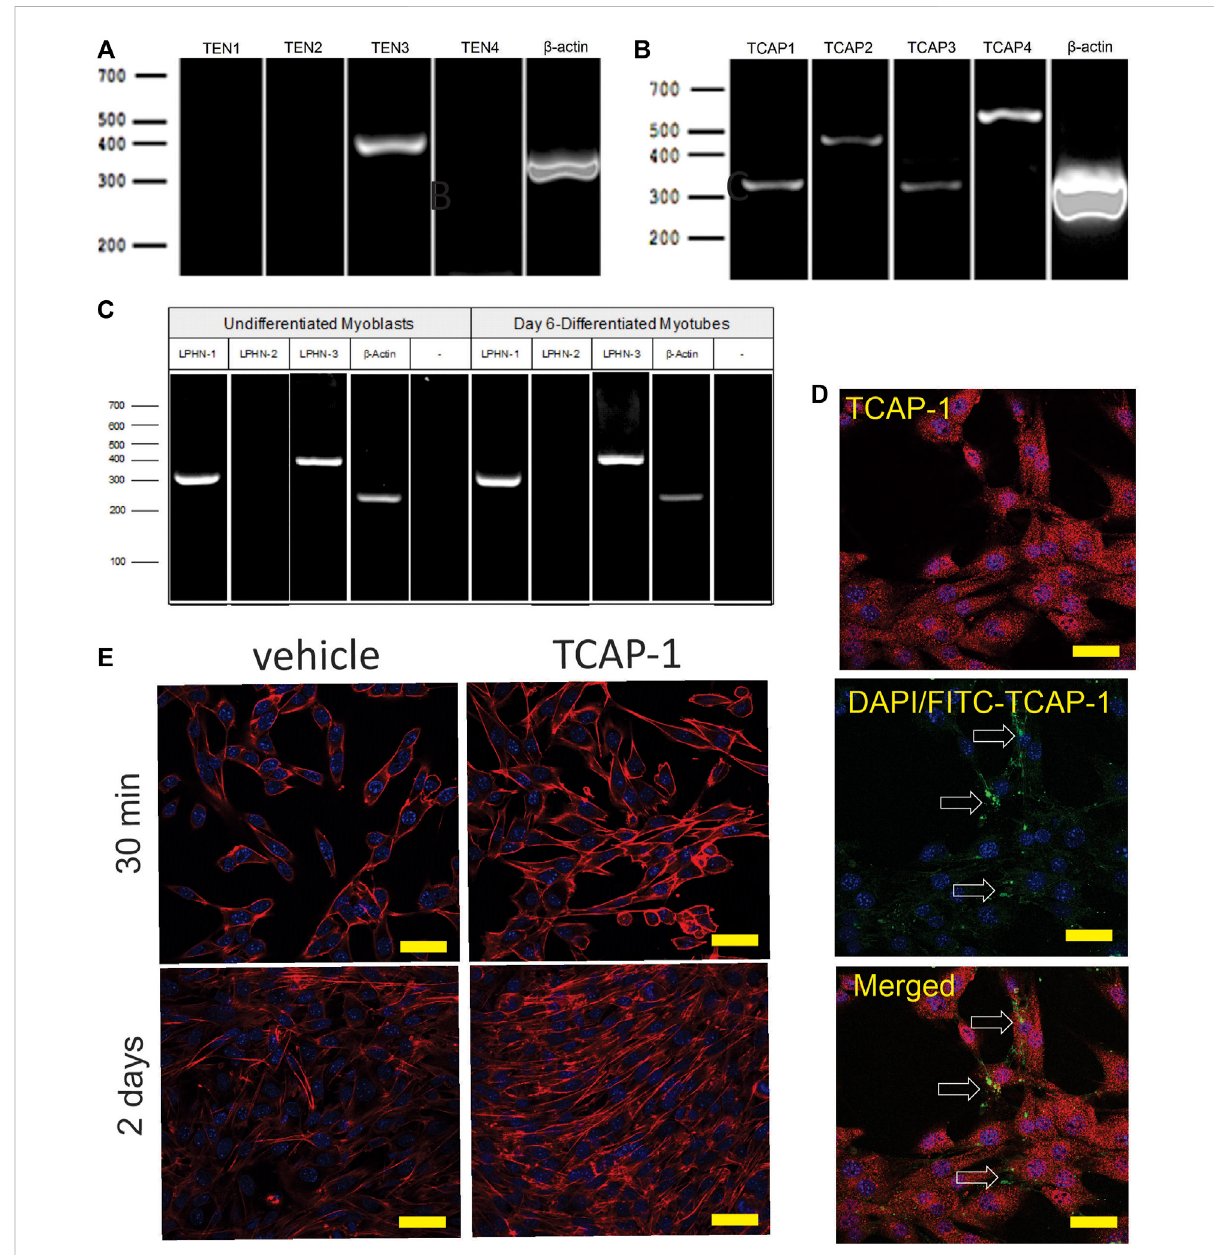
FIGURE 6 Expression of teneurin, TCAP and LPHN in C2C12 myoblasts. (A) . PCR-based teneurin expression; (B) . PCR-based TCAP expression; (C) . PCR- based LPHN expression. (D) . C2C12 cells labelled with TCAP-1 antisera showing the difference between the endogenous ir-TCAP and the presence of FITC-TCAP-1 localization. ir-TCAP-1 is indicated in red, whereas the DNA-associated DAPI labelling is indicated in blue. FITC-labeled TCAP-1 is shown in green. Arrows indicate regions of FITC-TCAP-1 uptake. Scale bars indicate 50 μ M (E) . Actions of TCAP-1 on the proliferation of the C2C12 myoblasts when treated with TCAP-1 at 30 min and 2 days. Actin is indicated in red, whereas the nuclei are indicated in the DAPI-based blue. Scale bars indicate 100